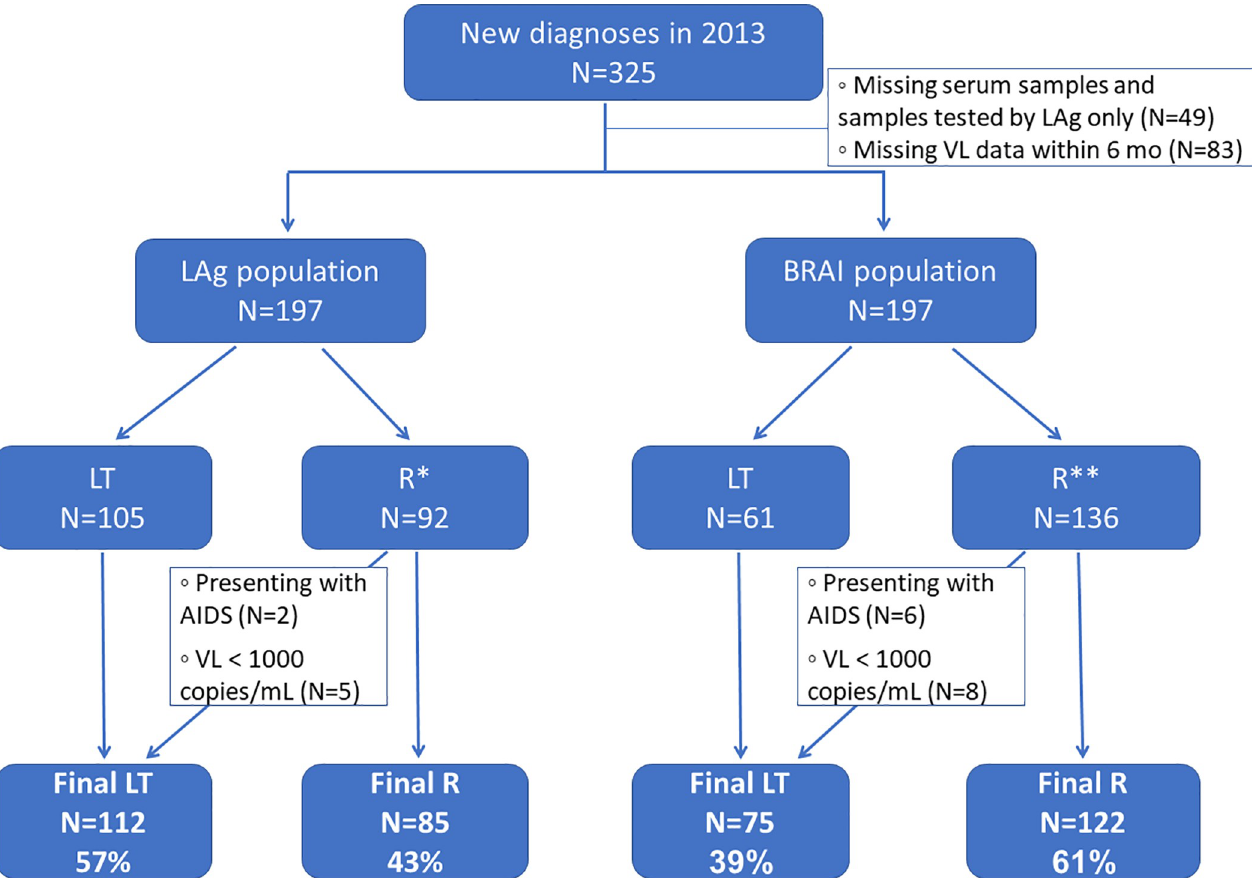
Fig 3. Reclassification of recent (R) and long-term (LT) infections by LAg and BRAI after including clinical data into the testing algorithm. � R by LAg includes 34 LAg-pending; �� R by BRAI includes 14 BRAI-invalid samples with available viral load (VL) results performed within six months of serum